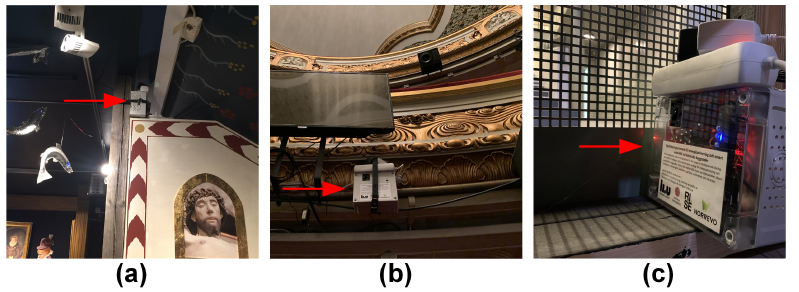
Figure 7. The deployments in the following: ( a ) the City Museum, ( b ) the City Theatre, and ( c ) the